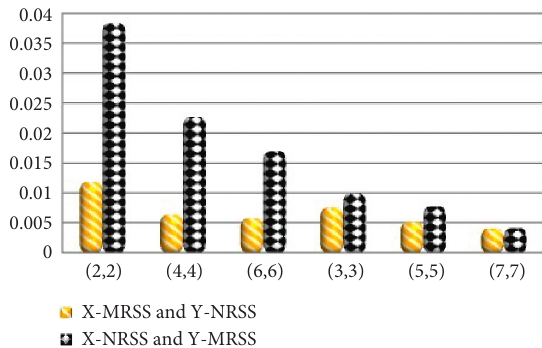
Figure 7: MSE of SSR estimate based on MRSS and NRSS at R � 0.556.